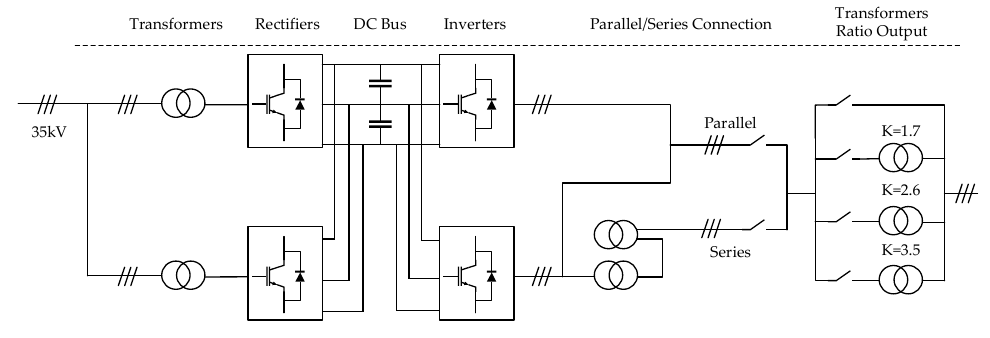
Figure 1. Overall structure of converter.